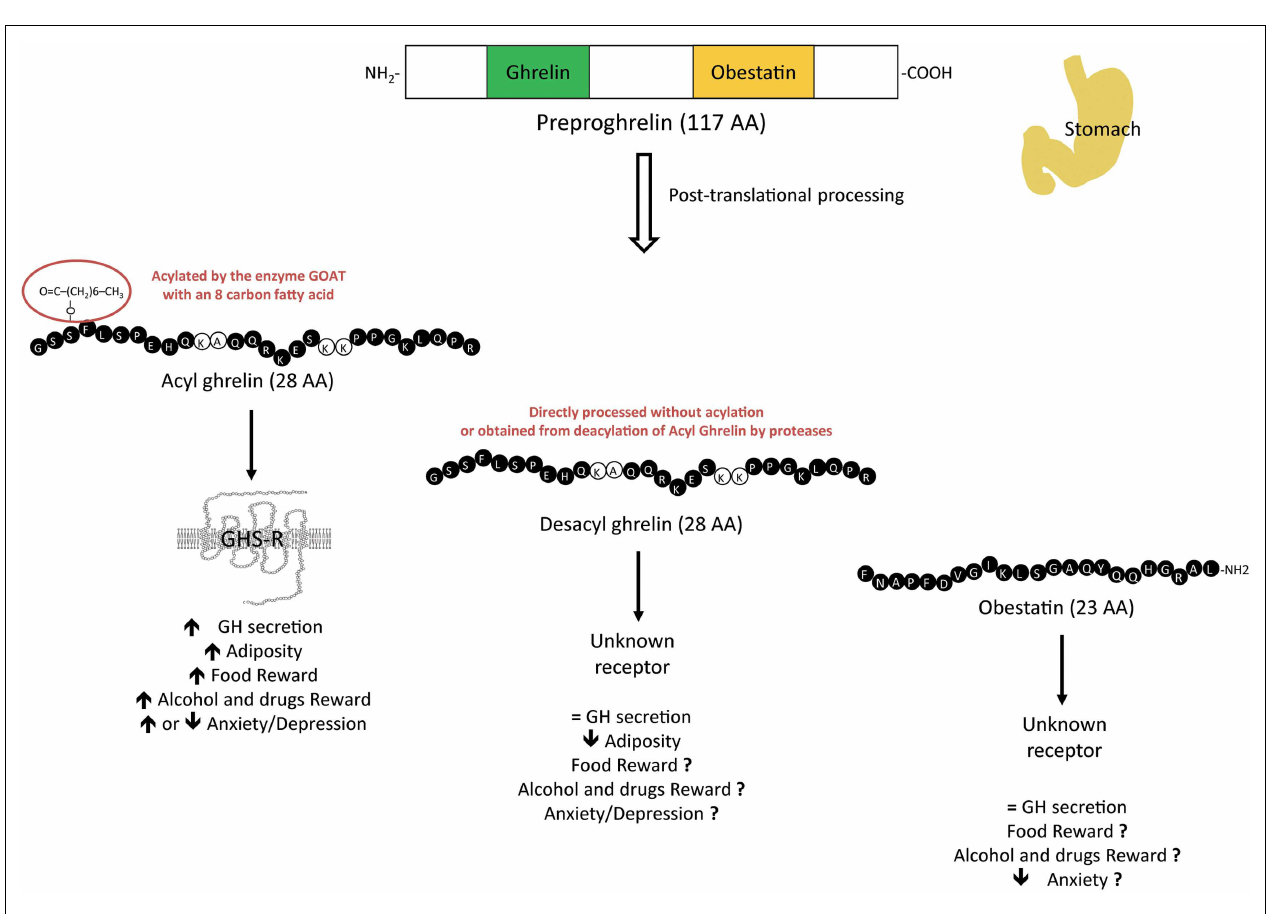
heterogeneity.Whereas the contribution of acyl ghrelin, which binds to the GHS-R1a, has been well explored, the roles of the other variants, desacyl ghrelin, and obestatin, through receptors that still need to be identified, in these regulations need to be